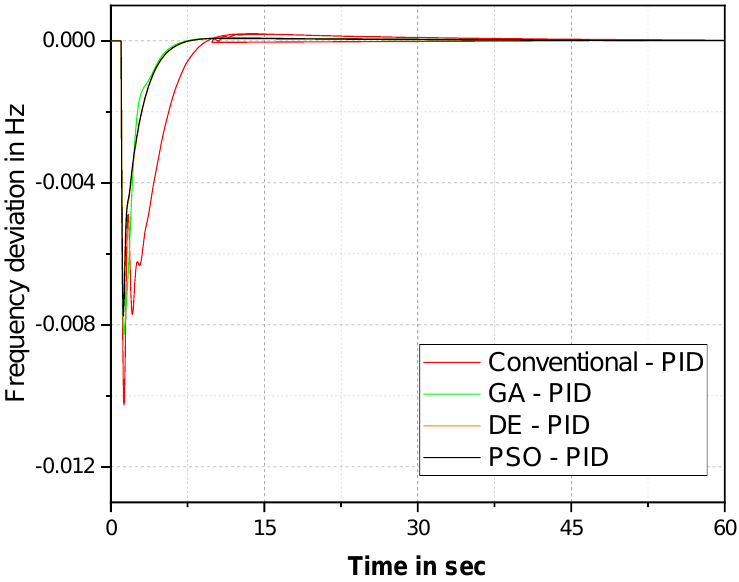
Figure 9. delF comparison for the ITSE cost function. Table 6. Controlled parameters of delF using the ITSE cost function.